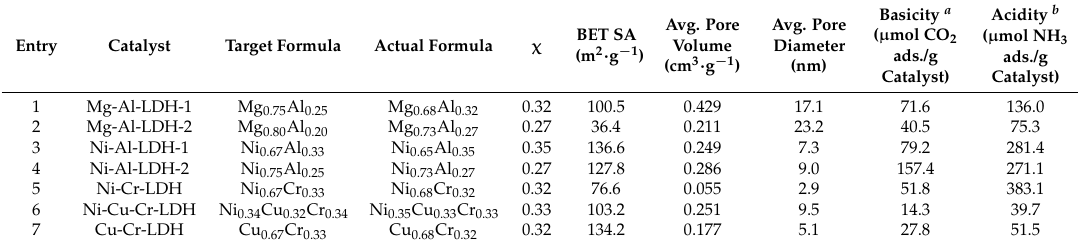
Table 1. Elemental analysis and gas adsorption data for LDH catalysts.